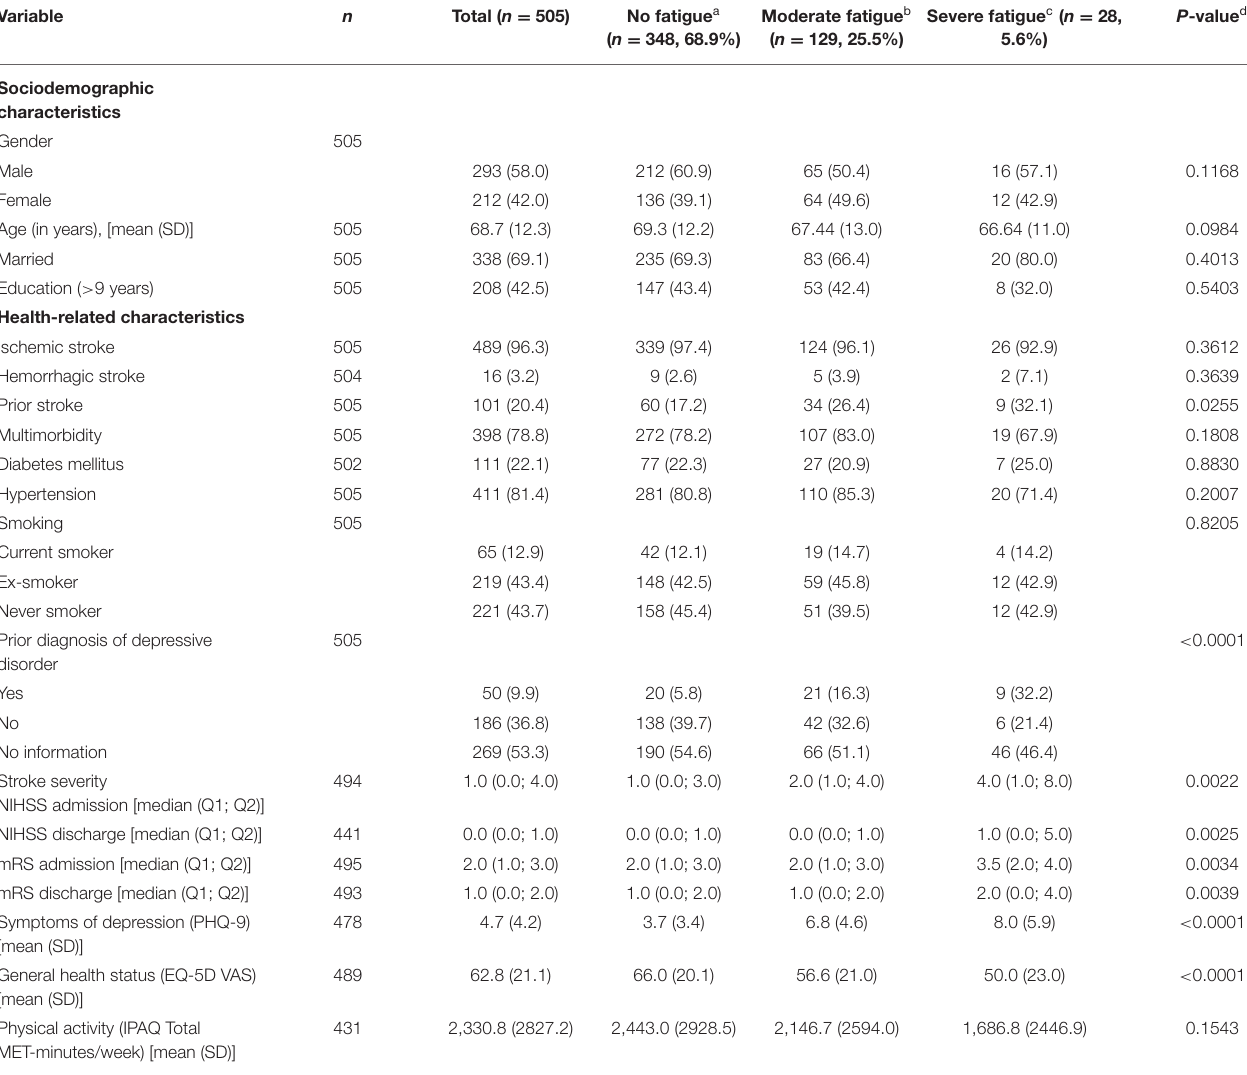
TABLE 2 | Sample characteristics, total sample and stratified by fatigue severity at 3 months post-stroke ( n , %).